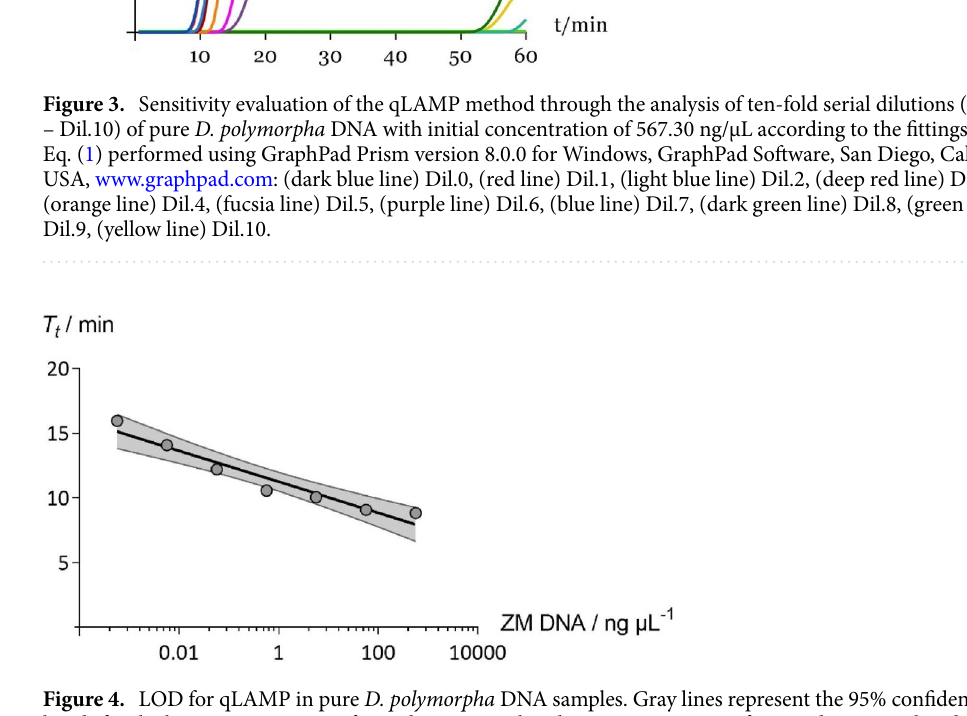
Figure 4. LOD for qLAMP in pure D. polymorpha DNA samples. Gray lines represent the 95% confidence bands for the linear estimation performed using GraphPad Prism version 8.0.0 for Windows, GraphPad Software, San Diego, California USA, www. graph pad.